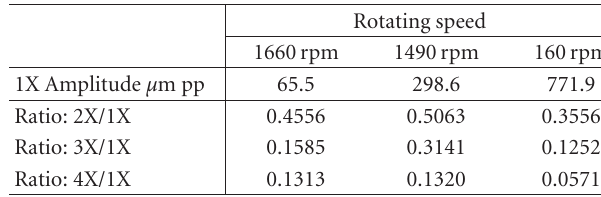
Table 2: Harmonic content of the key-phasor signal measured dur- ing the coastdown: e ff ects of the rub